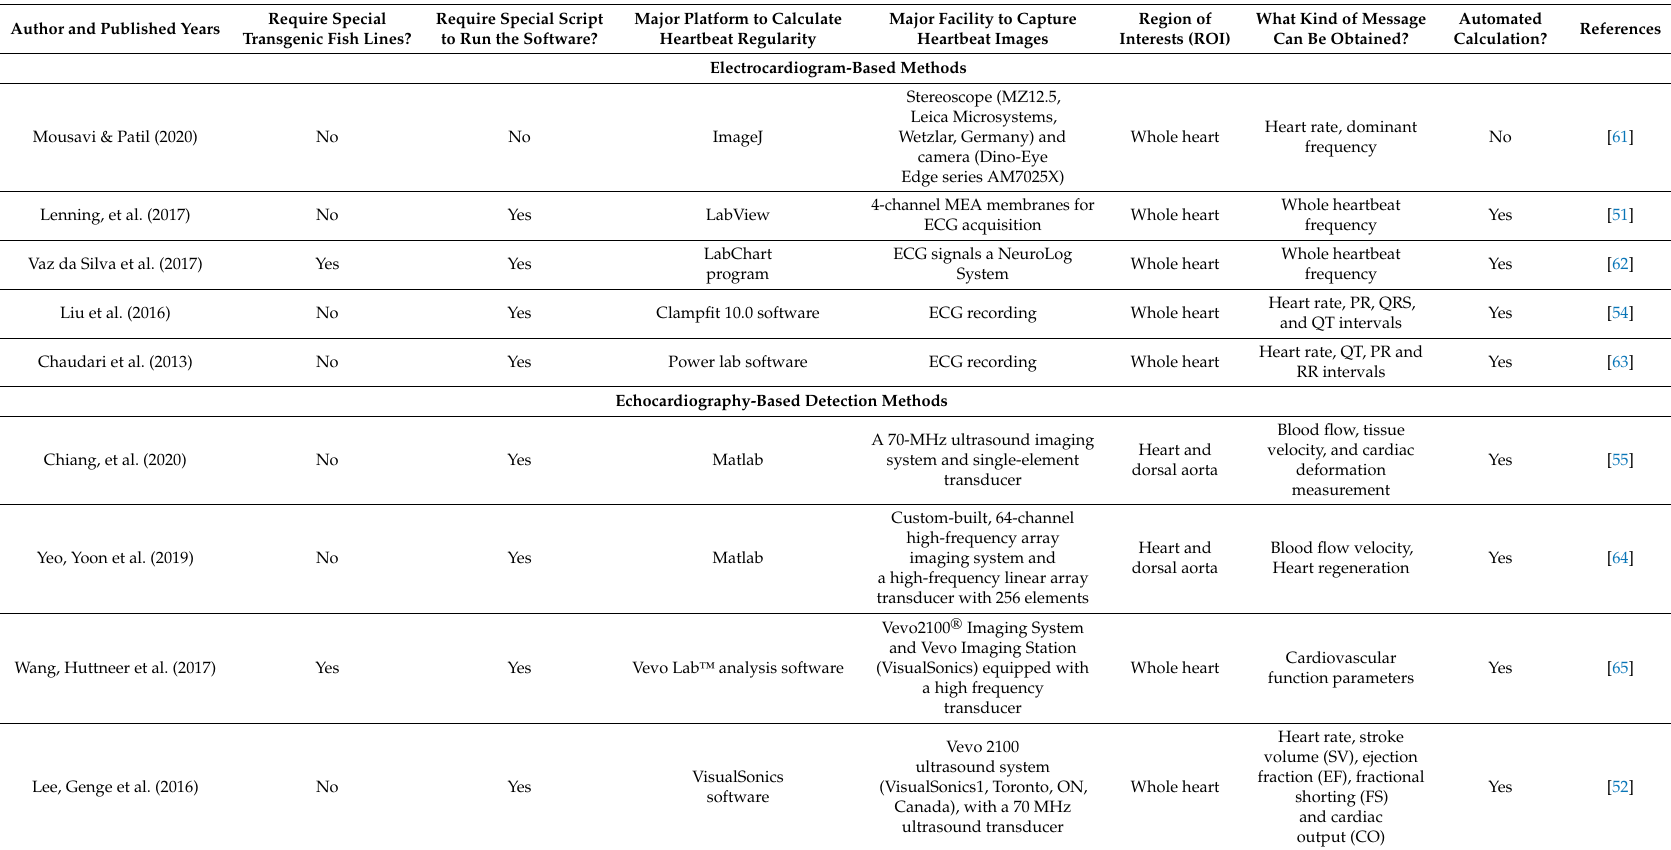
Table 2. Comparison of the methods for cardiac rhythm detection in adult